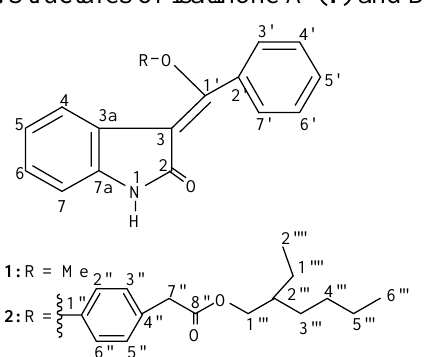
Figure 1. Structures of isatinone A ( 1 ) and B ( 2